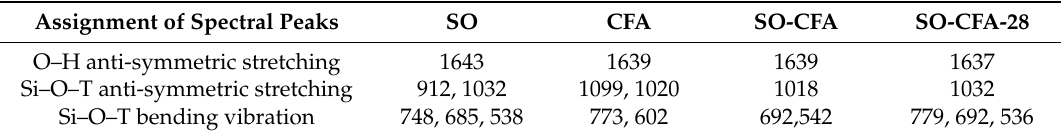
Table 4. Spectral peaks